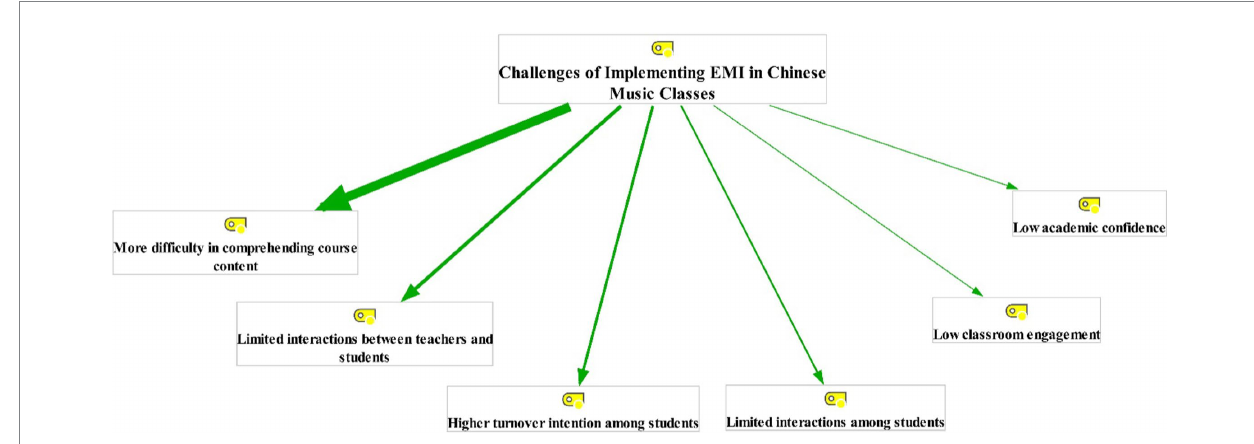
FIGURE 2 Challenges of implementing English as a medium of instruction (EMI) in Chinese music classes (the thicker the line, the more recurrent the